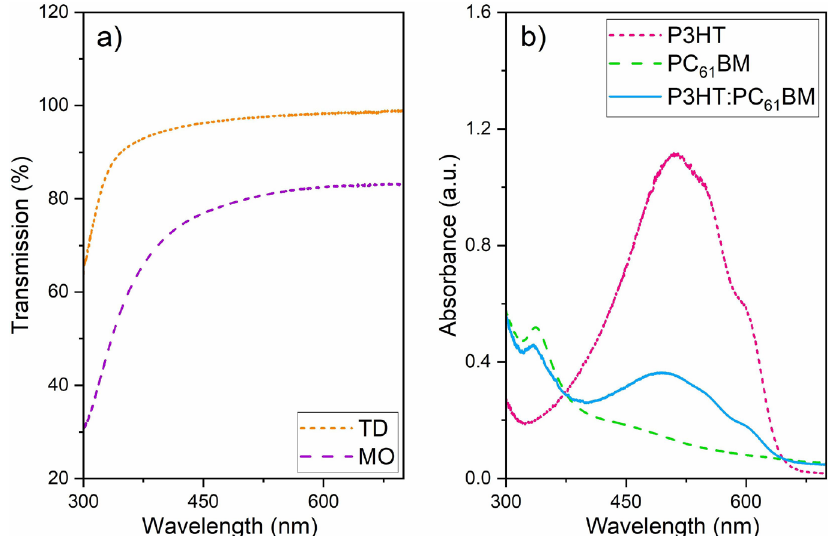
(TD) and b) MoO (MO) Figure 2. Tauc plots of a) TiO 2 3 1386 cm -1 represents the C-C bond of the main structure 25 . Figure 5 shows the 2D and 3D AFM images of TiO Also, vibrational modes at 1449 cm -1 and 1469 cm -1 are MoO films with dimensions of 10 µm x 10 µm. For TiO 3 related to the C=C bond in aggregate and non-aggregated chains of P3HT thiophene ring 24-26 . Finally, the observed vibrational mode at 2889 cm -1 corresponds to the C-H bond 25 . XRD patterns of TiO and MoO samples are shown in 2 3 Figure 4. The observed diffraction planes of (101), (004), (200), (105), (204), (116) and (115) attributed to the anatase phase of TiO (JCPDS 21-1272) 27 . Moreover, MoO thin film 2 3 showed (210) , (300), (220), (310), (320), (410), (008), (218), (424) and (524) planes, which correspond to the amorphous hexagonal phase: h -MoO (JCPDS 21-0569) 28,29 . 3